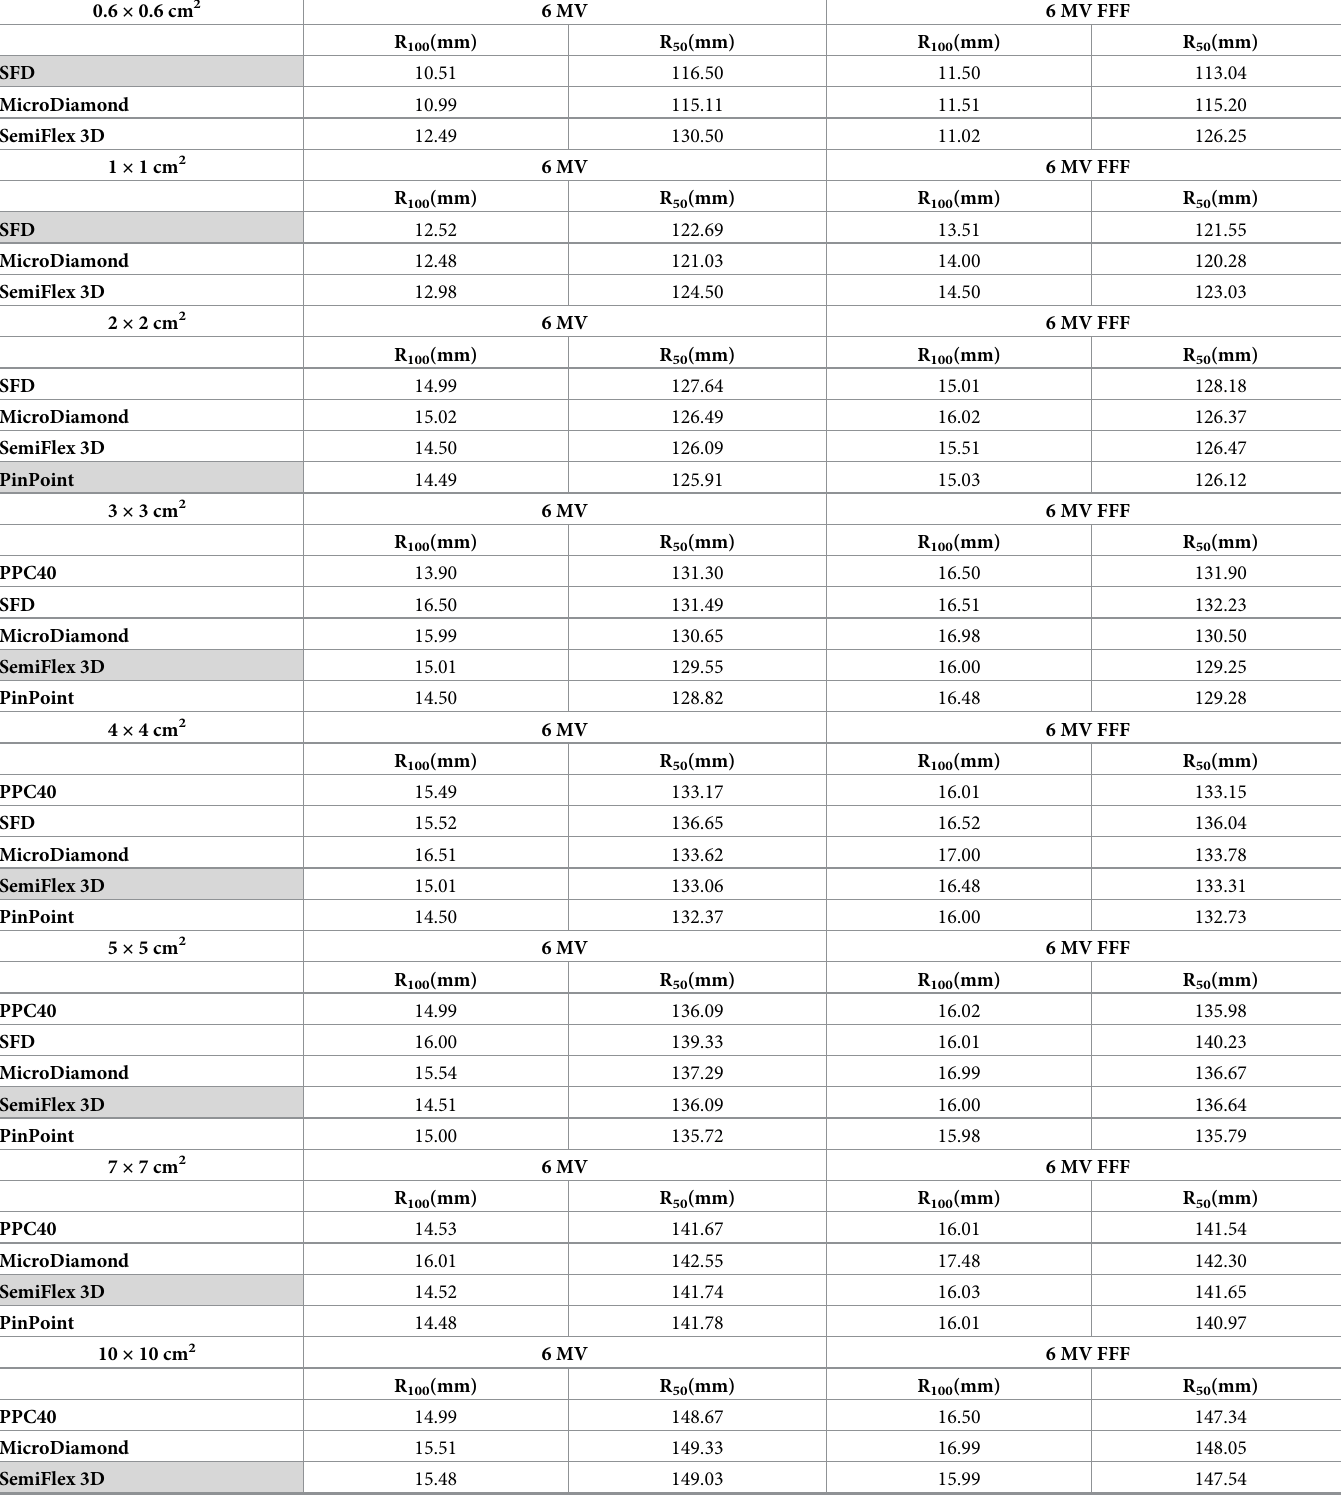
Table 8. Results of the parameters for different detectors depending on the field size for 6 MV and 6 MV FFF